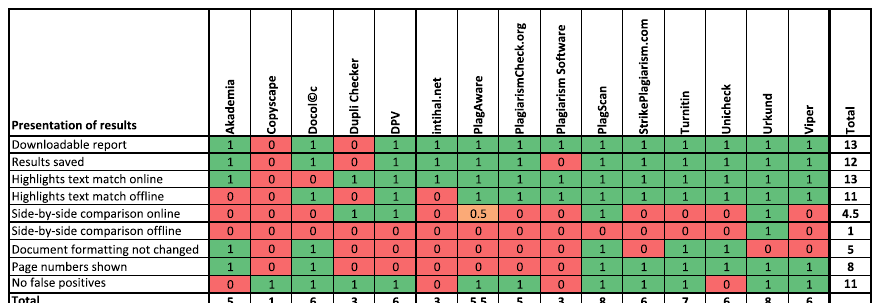
Table 10 Usability evaluation: Presentation of